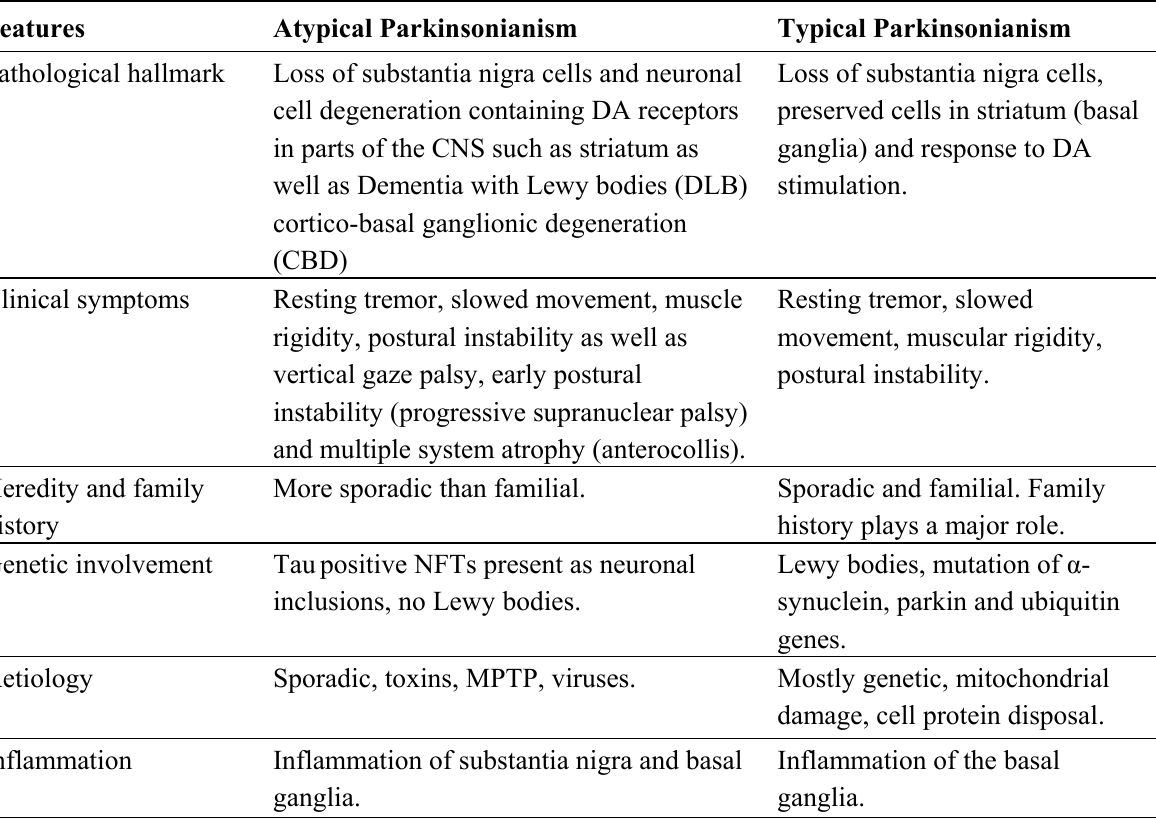
Table 2. Clinical symptoms of atypical and typical